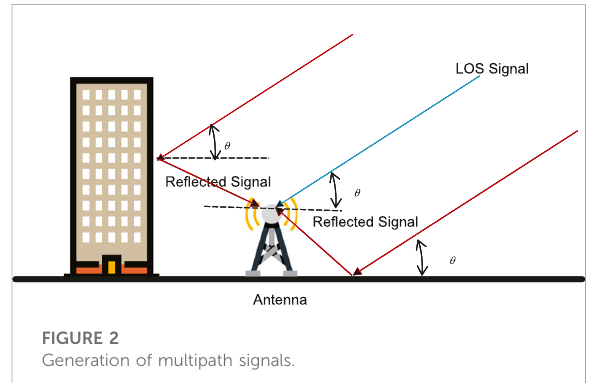
FIGURE 2 Generation of multipath